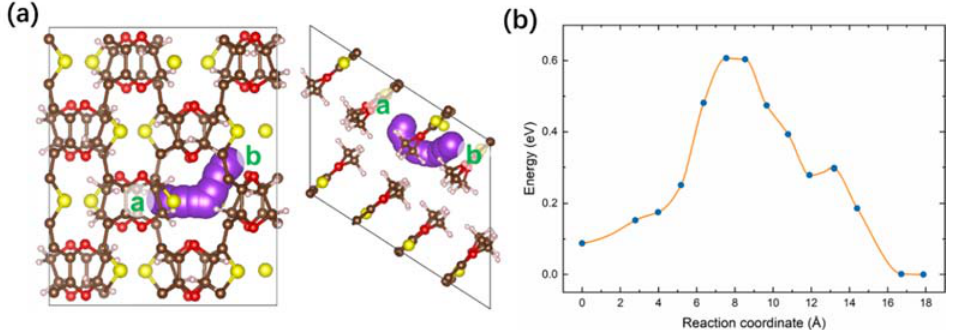
Figure 7. ( a ) Schematic diagram of diffusion pathway in the PEDOT , and ( b ) the energy profile of the K diffusion from sites a to b.